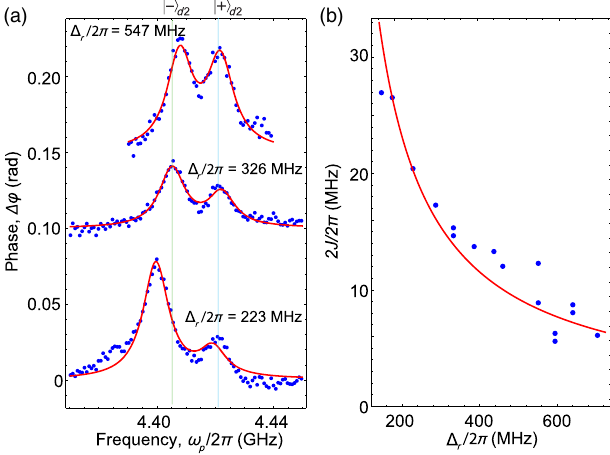
FIG. 4. Coherent qubit-qubit exchange splitting 2 J vs resonator Φ Þ . (a) Resonator phase shift (data points offset for detuning Δ r ð clarity) measurement performed to extract qubit-qubit interaction 2 J on resonance for the indicated detunings Δ Φ Þ . Solid lines r ð are fits to master-equation simulations; see Appendixes C and H for details and parameters. (b) 2 J extracted from (b) and similar data vs Δ . The solid line is a fit to 1 = Δ r r 2 .